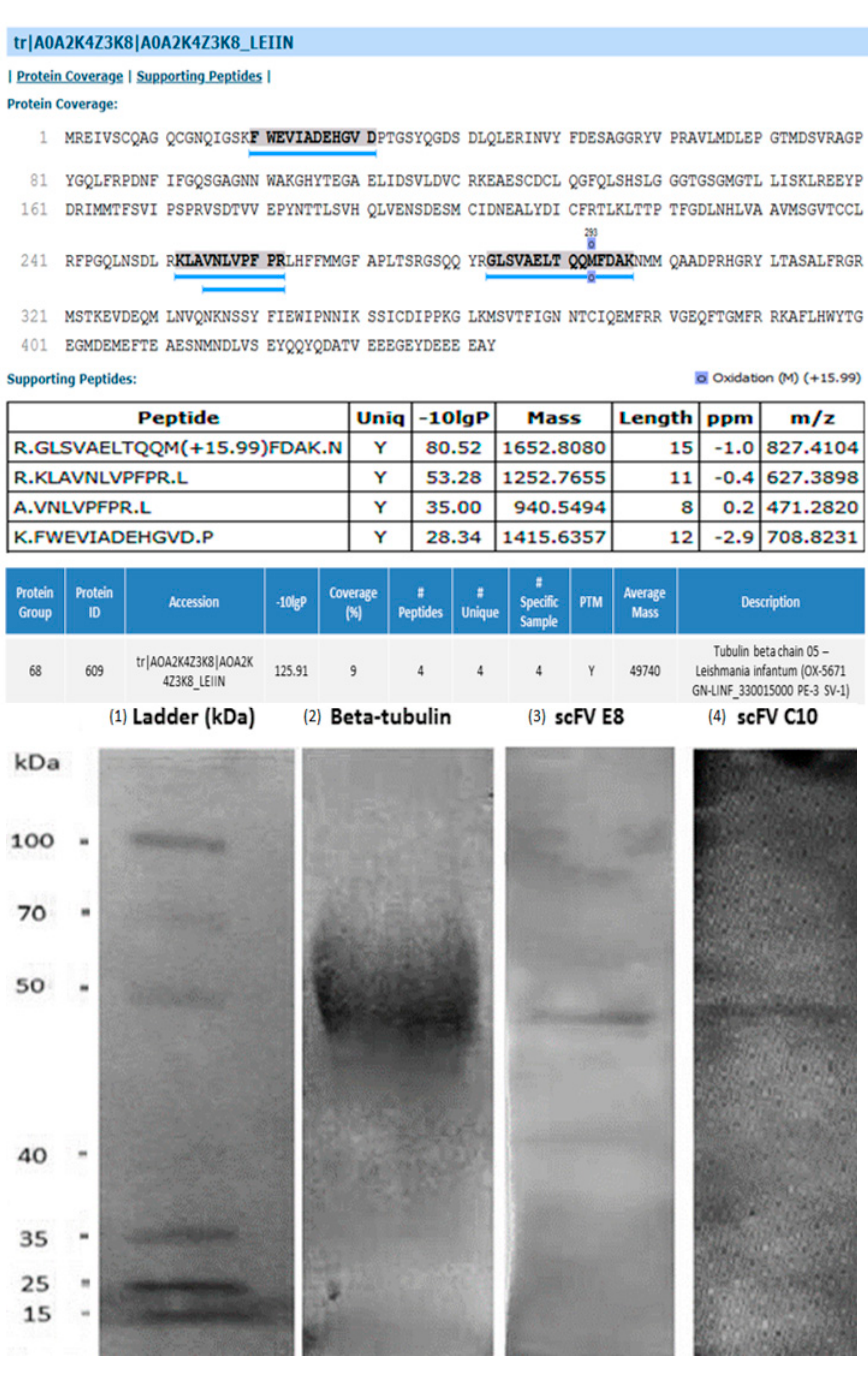
Figure 4. Identification of Leishmania β -tubulin protein. The target protein was identified by mass spectrometry ( A ) and immunoblotting reaction ( B ) against the selected monoclonal antibodies. Immunoblotting experiments using the scFv-E8 and scFV-C10 antibodies were performed for confirmation of the target protein. SDS-PAGE gel followed by Western blot assay confirmed that both monoclonal antibodies recognized the β -tubulin protein, presenting a molecular weight of 49.8 kDa. (1) Protein molecular weight marker (in kDa). (2) The recombinant β -tubulin protein reacting against the anti-Histidine monoclonal antibody. The reaction of the scFv-E8 and scFV-C10 antibodies with the purified protein is shown (in (3) and (4), respectively).